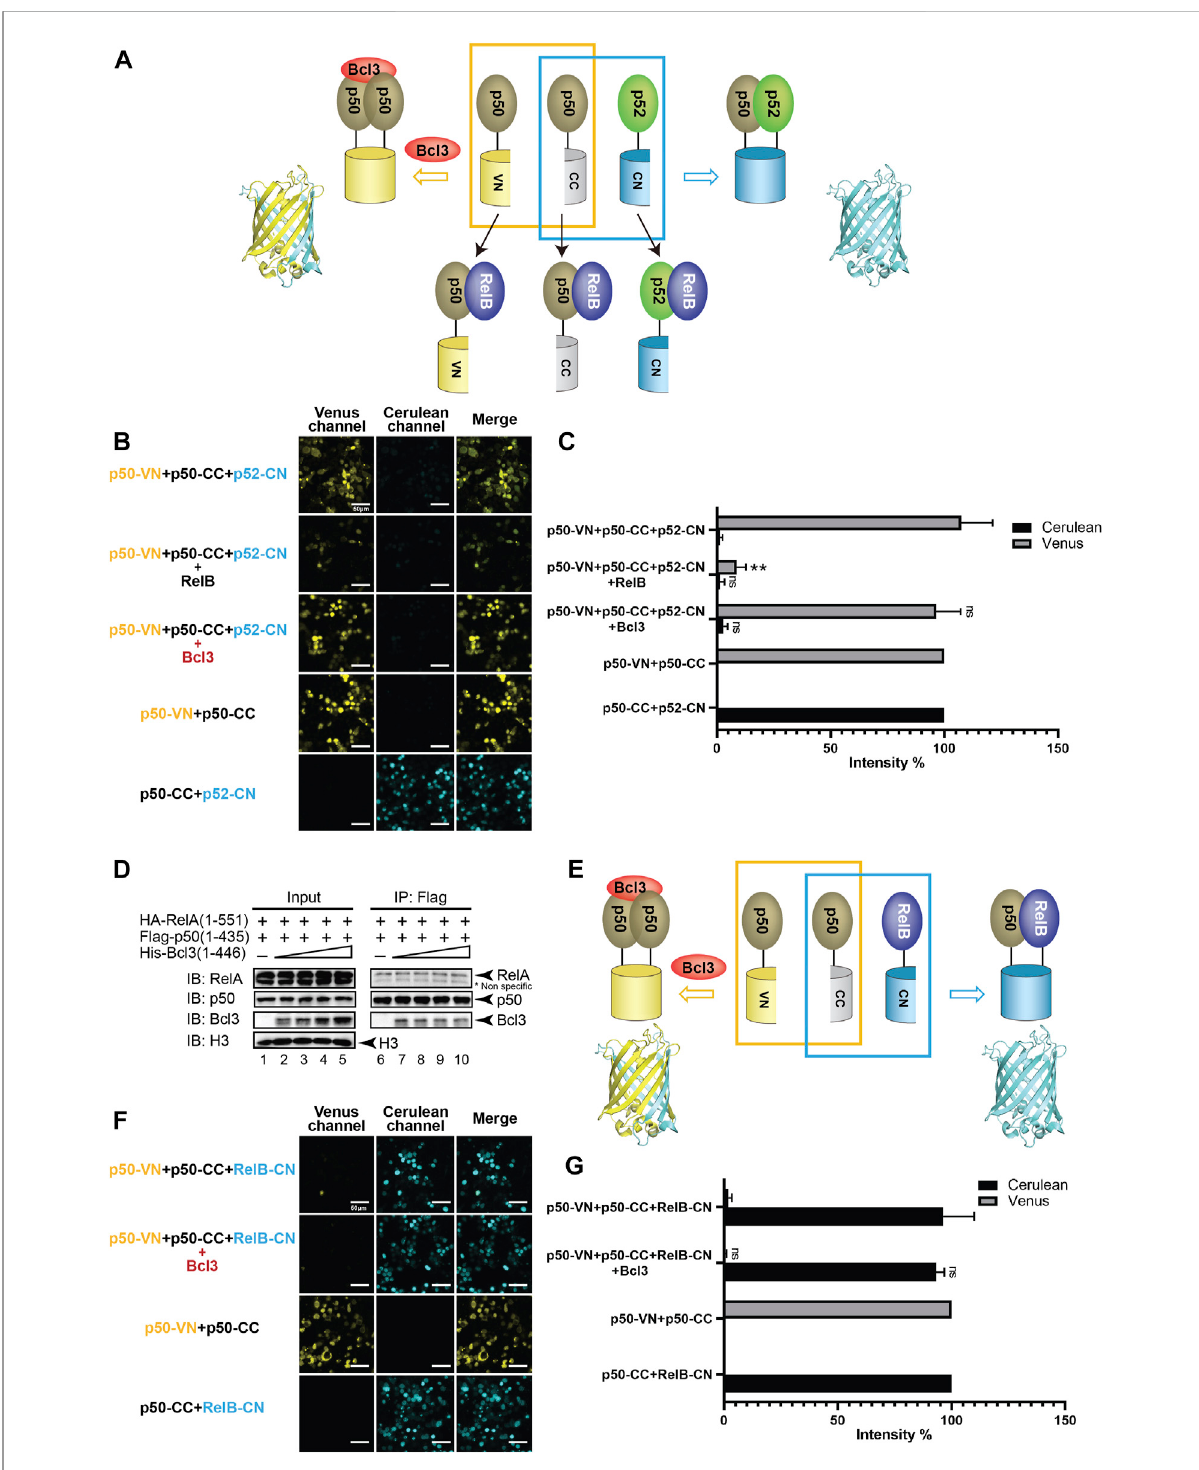
FIGURE 4 Bcl3 does not enhance the generation of the p50:p50 homodimer. (A) Diagram illustrating the principle of multicolor BiFC assay. The p50: p50 homodimer formation brings VN and CN together to form a fl uorescent protein which could be detected at the Venus channel; the p52: p50heterodimerformationbringsCCandCNtogethertoformanintactCeruleanproteinwhichcouldbedetectedusingtheCeruleanchannel.The additionofRelBwillheterodimerizewithp50orp52;therefore,bothp50:p50(Venus)andp52:p50(Cerulean)willbedecreased. (B) Fluorescent imageswiththeco-expressionofindicatedplasmids.Thep50:p50(Venus)isastrongerdimerthanp52:p50(Cerulean);andtheadditionofBcl3does